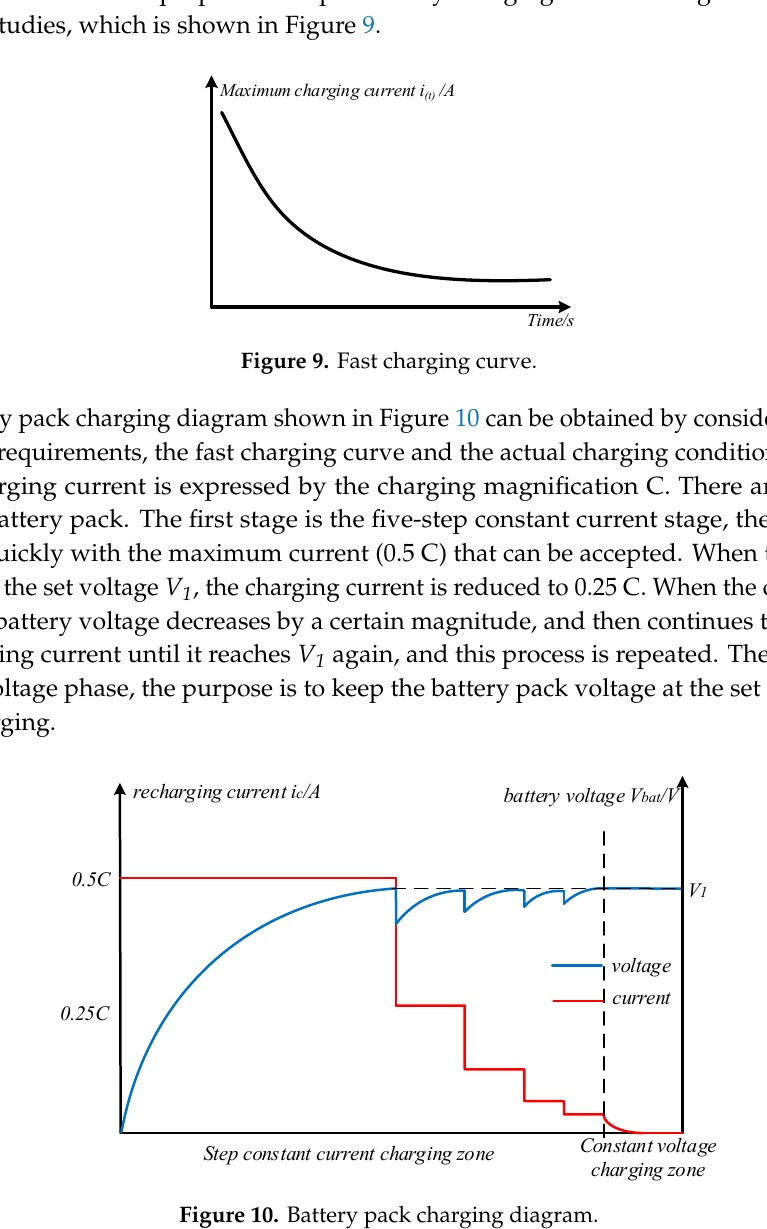
Figure 10. Battery pack charging diagram.